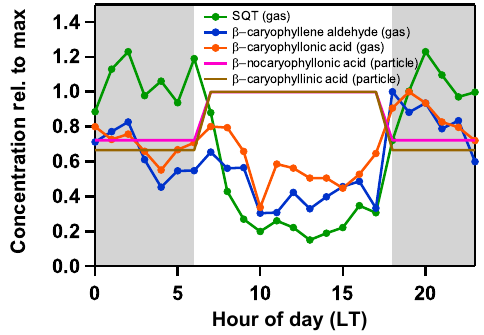
Figure 7. Diel profiles during the wet season of total sesquiterpenes (SQTs) and four β -caryophyllene oxidation products in gas and par- ticle phases. For each series, data are normalized by the maximum observed concentration within the series and shown as concentra- tion relative to max. Local nighttime hours indicated in